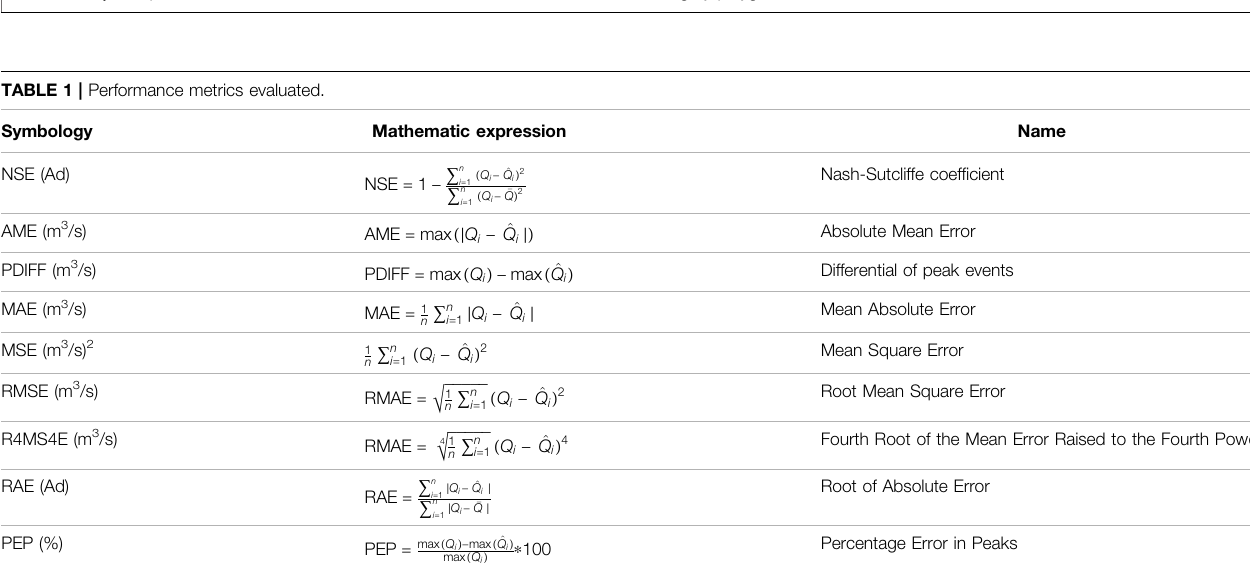
FIGURE 4 | Groups of HAUs related to fl ow stations. Uncalibrated HAUs are shown as gray polygons.